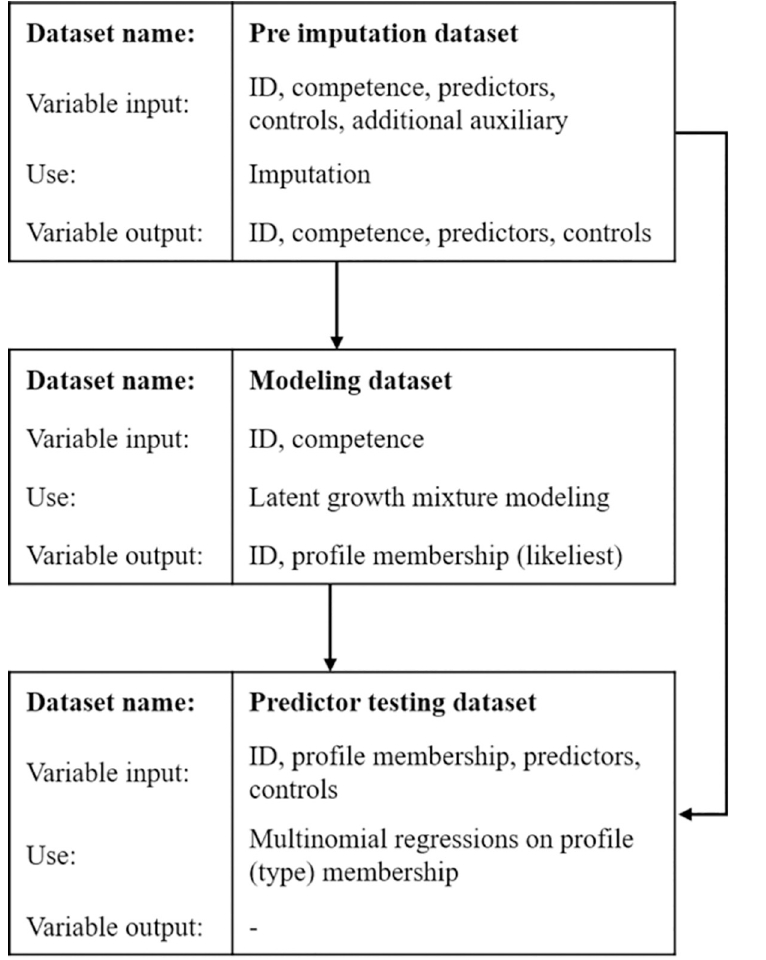
Fig 1. The three statistical steps, necessary datasets and variables.